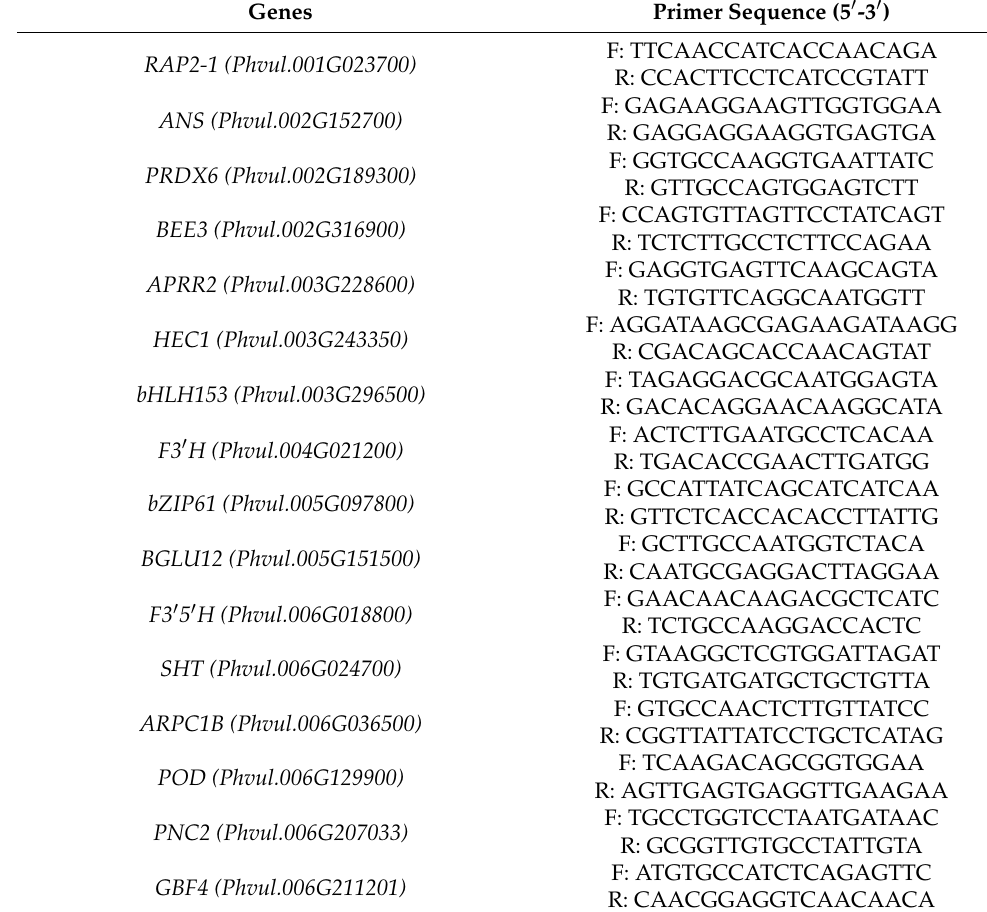
Table 6. Primers used for